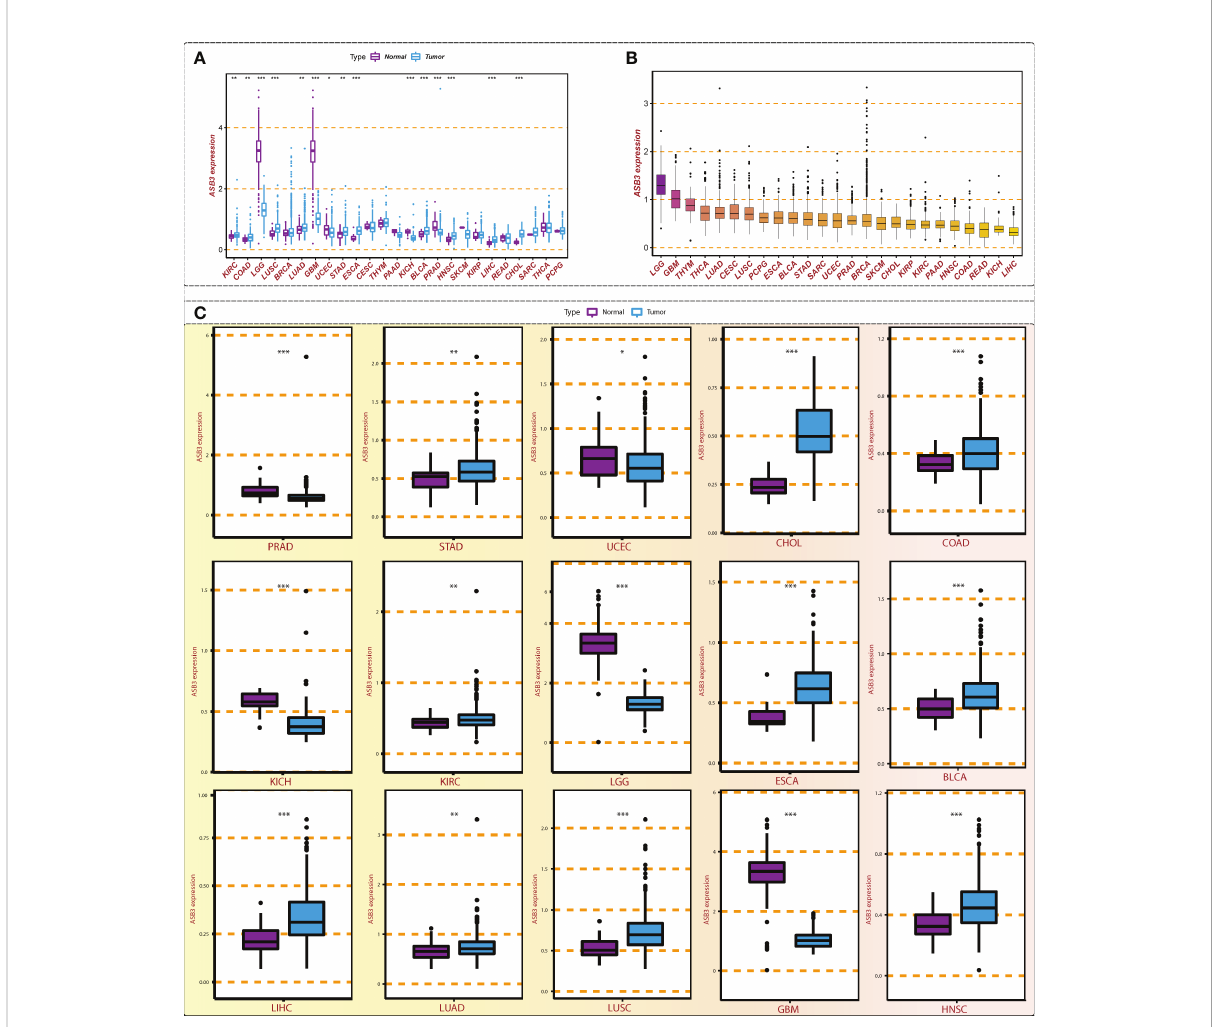
FIGURE 2 Expression level of ASB3 in pan-cancer. (A) ASB3 is abnormally expressed in different cancer types, up-regulated in 10 cancer types and down- regulated in 5 cancer types. (B) The level of ASB3 in pan-cancer, LGG and GBM have the highest level. (C) Box plots showing the signi fi cant different expression distribution of ASB3 across tumor and normal samples in 15 cancer types. * P < 0.05, ** P < 0.01, *** P <